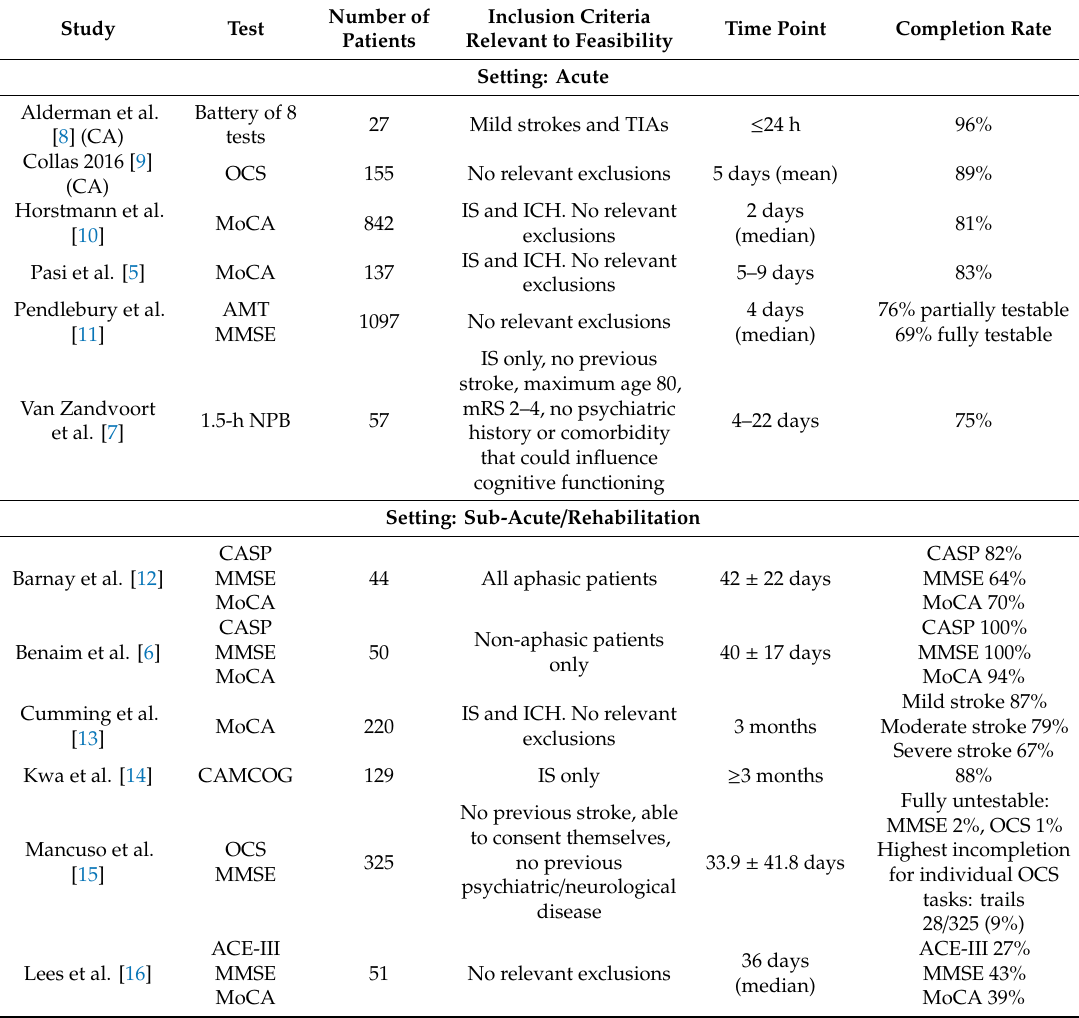
Table 1. Previous studies addressing feasibility of cognitive assessments